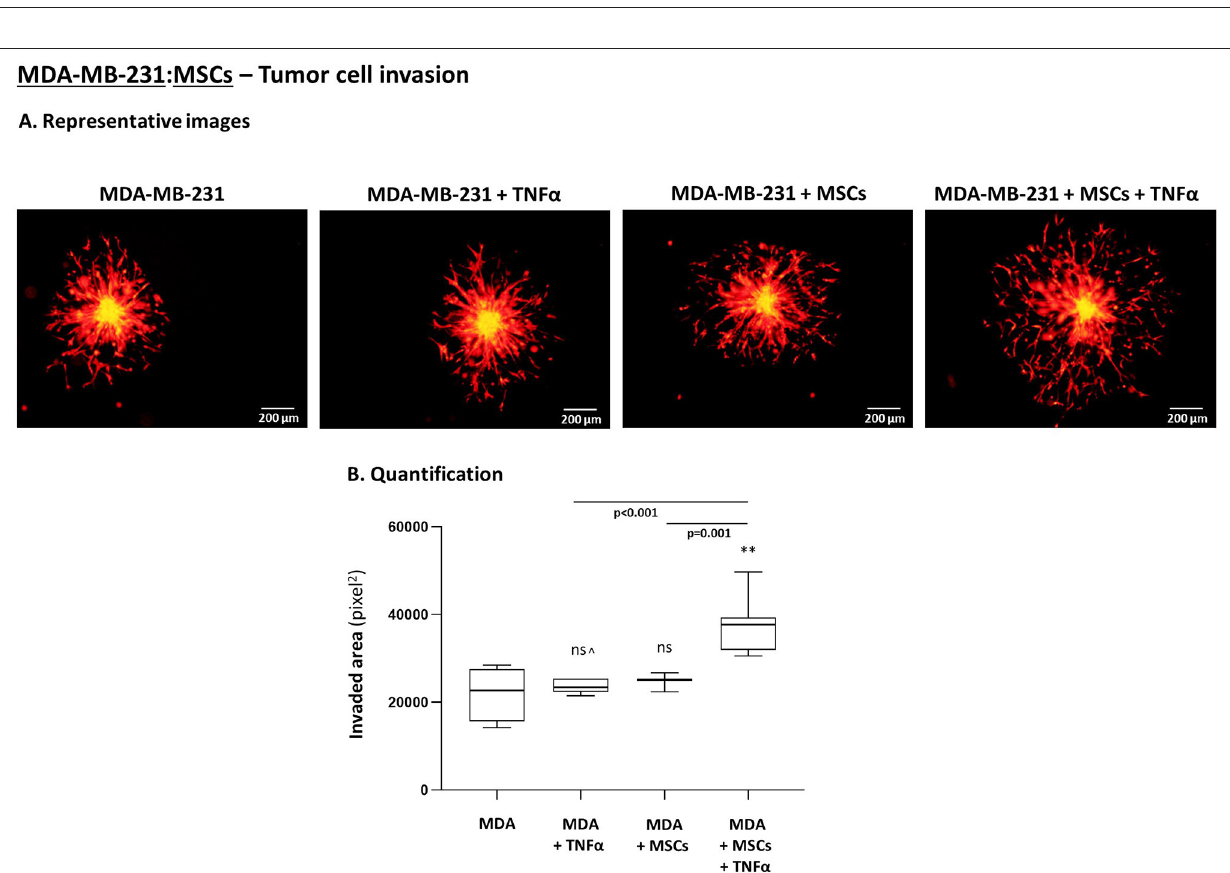
FIGURE 9 | compared to the migration of non-stimulated TNBC cells. ∧ In panel (A2) , this value was significant in 1 out of 3 experiments. Representative fluorescent photos of migrating cells are presented in Supplementary Figure 4 . In all sections of Part (A) , the Figures demonstrate representative experiments of n = 3 independent experiments of each type, performed with MSCs of ≥ 2 different donors. (B) Morphology and migration phenotypes of MCF-7 cells, determined as described in Part (A) , unless otherwise indicated. (B1) Morphology of mCherry-MCF-7 cells. Bar, 50 µ m. (B2) Migration of Hoechst-loaded MCF-7 cells was performed in response to medium containing 10% FBS for 21h through fibronectin-coated membranes, in similar combinations as of MDA-MB-231 cells in Part (A) (TNF α : 10ng/ml). *** p < 0.001; Representative photos of migrating cells are presented in Supplementary Figure 5 . In all sections of Part (B) , the Figures demonstrate representative experiments of n ≥ 3 independent experiments, performed with MSCs of ≥ 2 different donors.